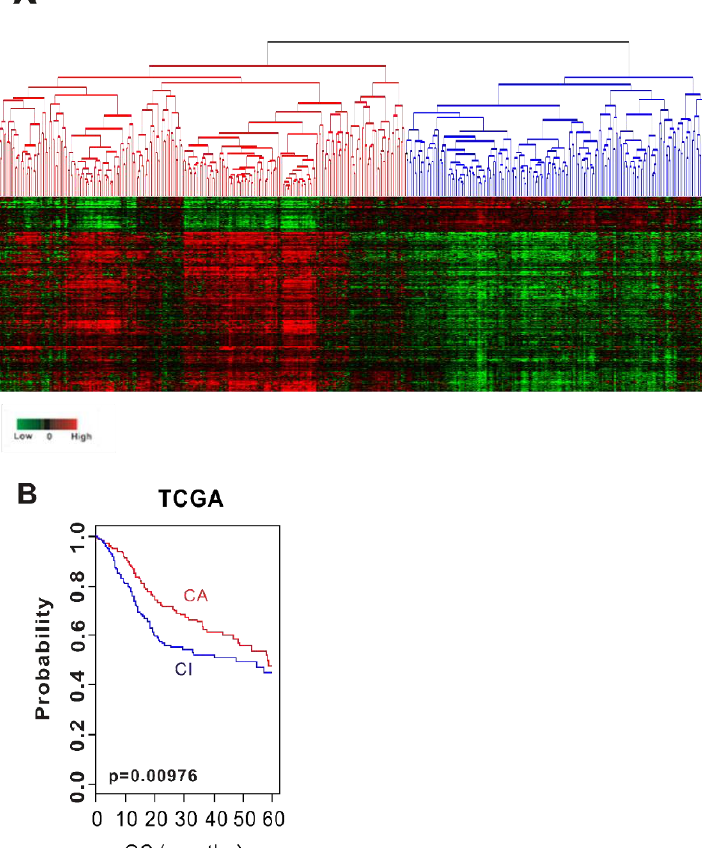
Figure 1. Stratification of HNSCC patients in the TCGA cohort with CSMD1 signature. ( A ) Hierarchical clustering of CSMD1 expression data in the TCGA cohort. ( B ) Kaplan–Meier plots of overall survival (OS) at 5 years of patients with HNSCC in the TCGA cohort.